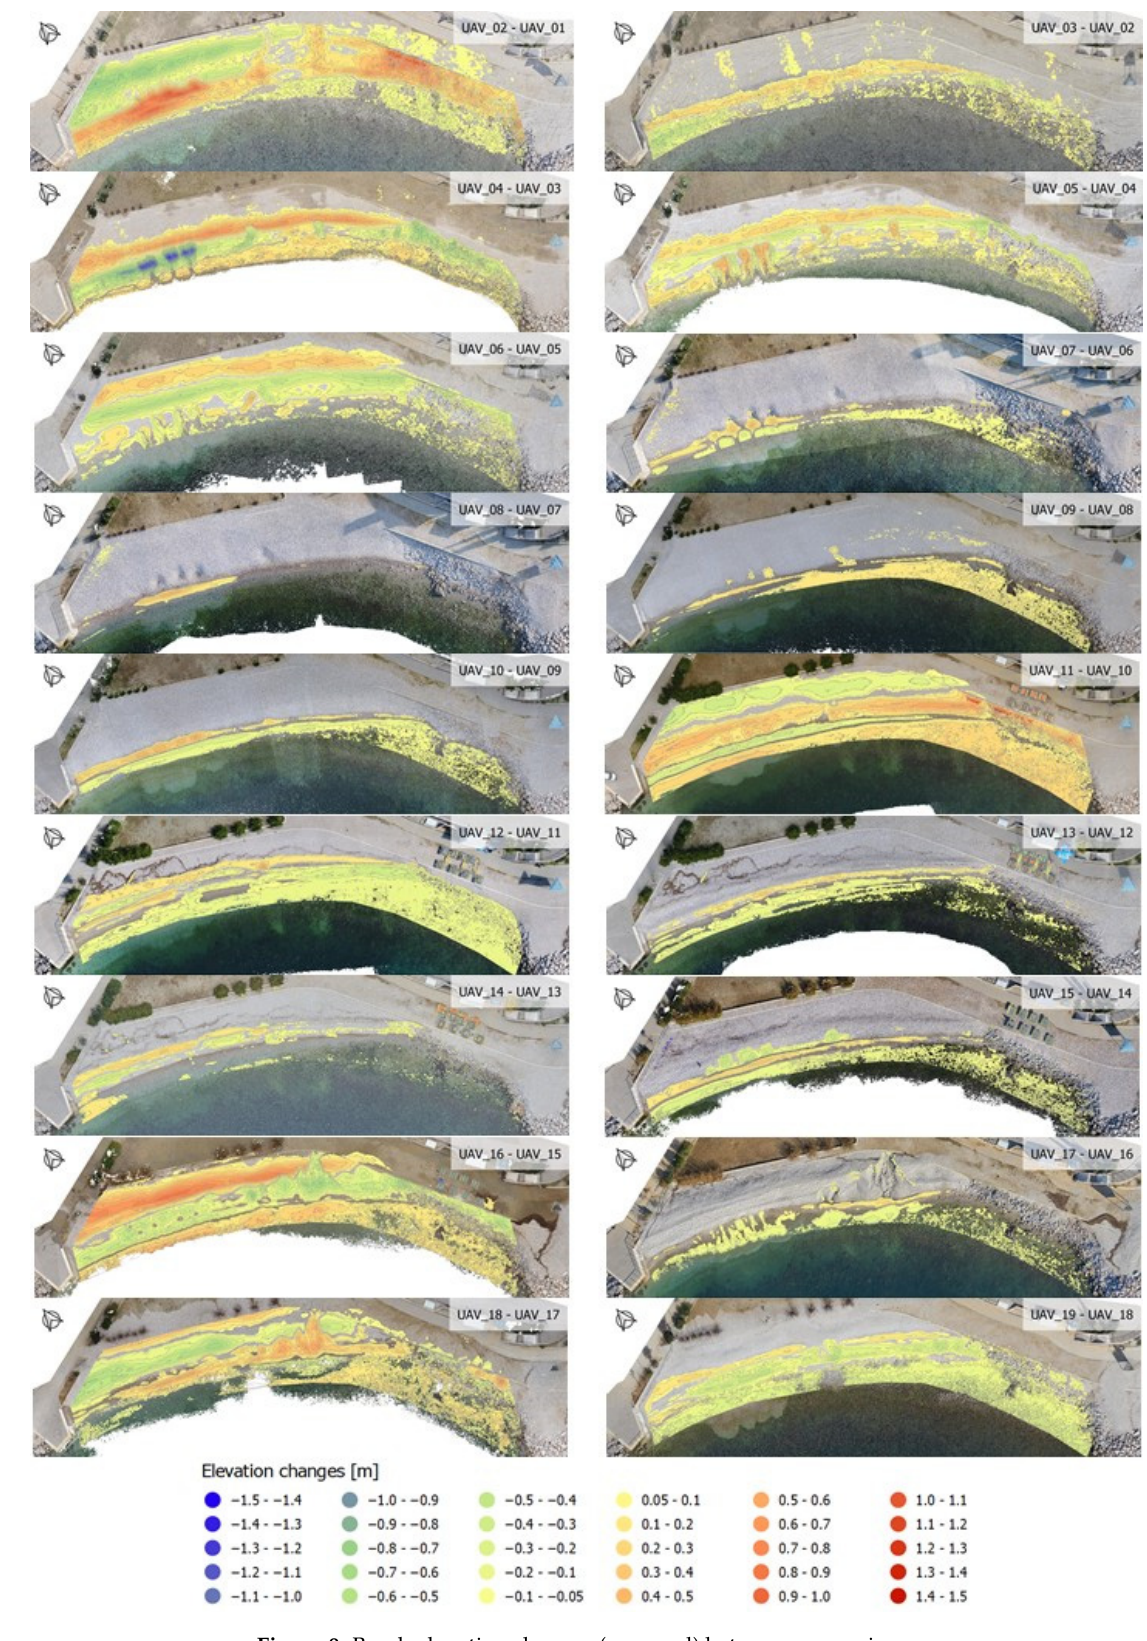
Figure 9. Beach elevation changes (emerged) between successive surveys.